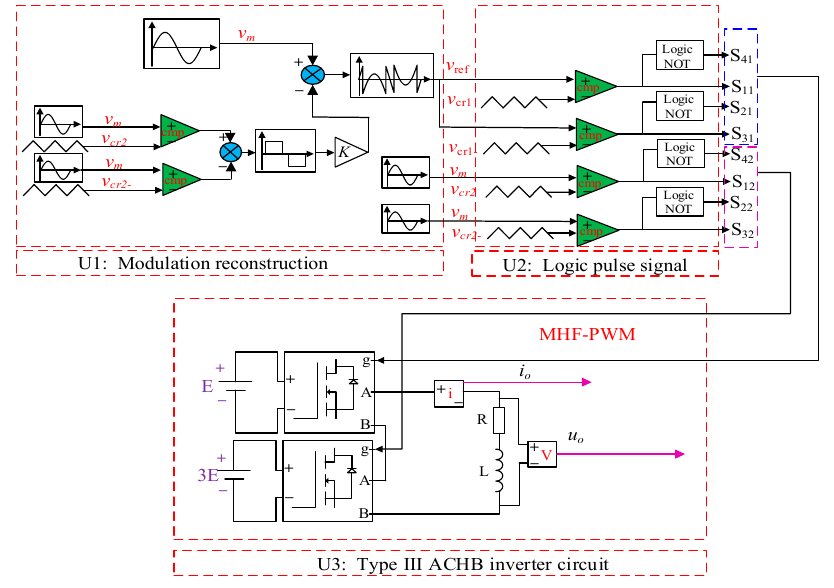
Figure 10. Driving logic signal generating circuit of MHF-PWM.